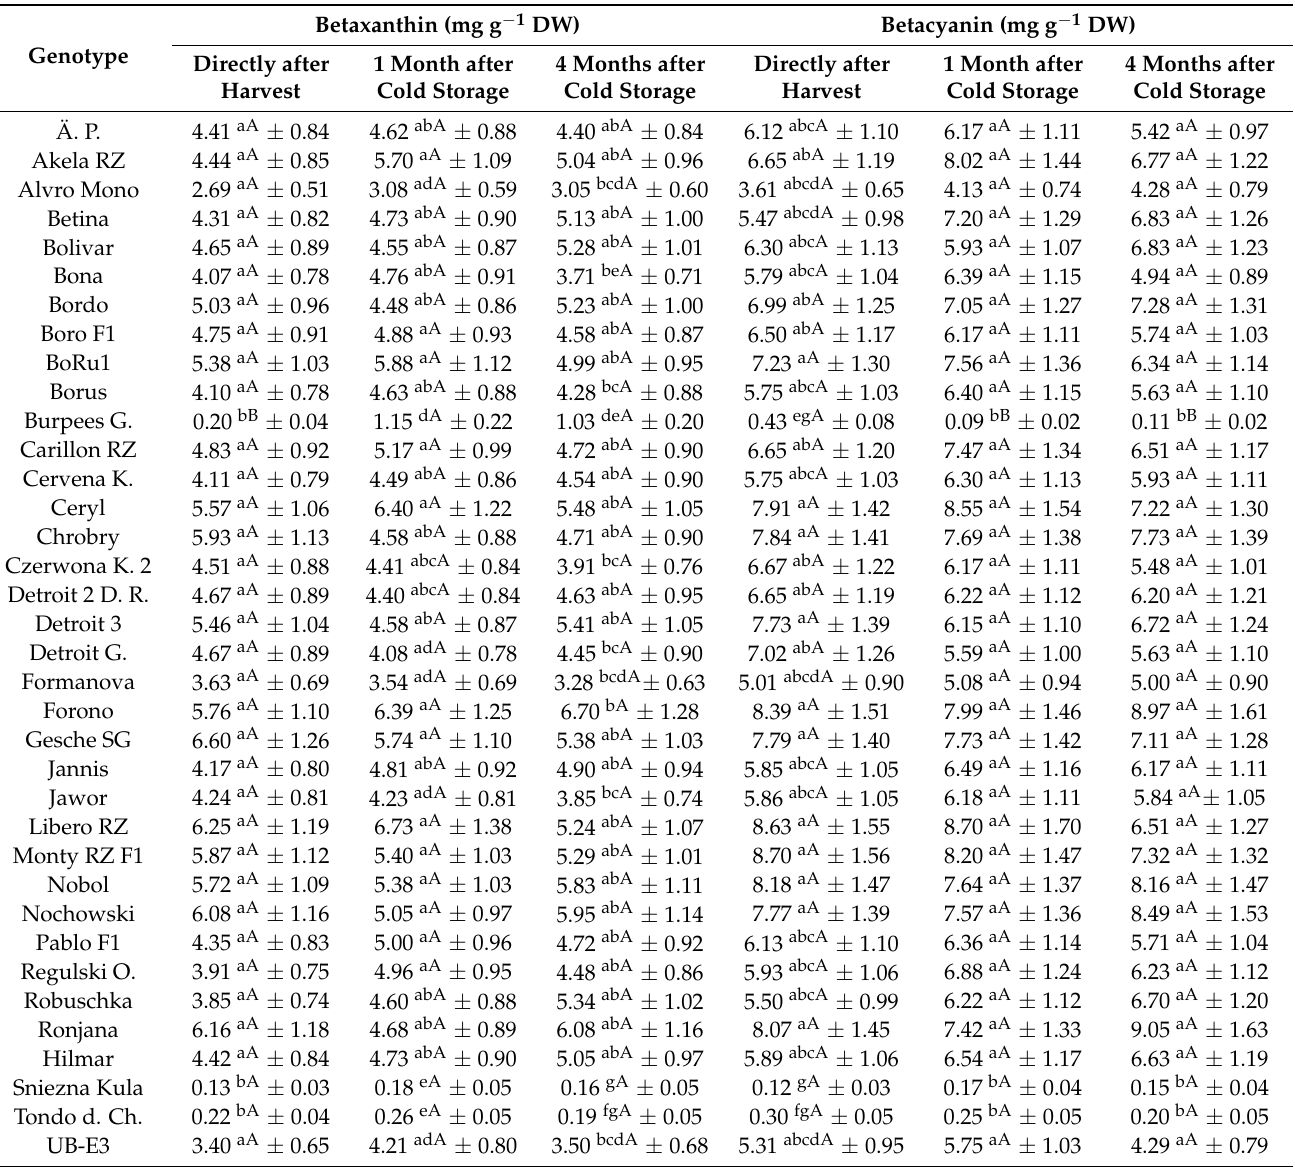
Table 4. Median values of betaxanthin (mg g − 1 DW) and betacyanin (mg g − 1 DW) of 36 beetroot genotypes grown at the research station Kleinhohenheim within the years 2017 and 2018, directly after harvest, and after the cold storage periods of one and four months. Results represent the median values ± approximate standard error. Medians followed by at least one identical lower-case letter in one column did not differ significantly between genotypes at experiment-wise Type 1 error α = 0.05. Medians followed by at least one identical upper-case letter in one row did not differ significantly between storage periods at experiment-wise Type 1 error α =